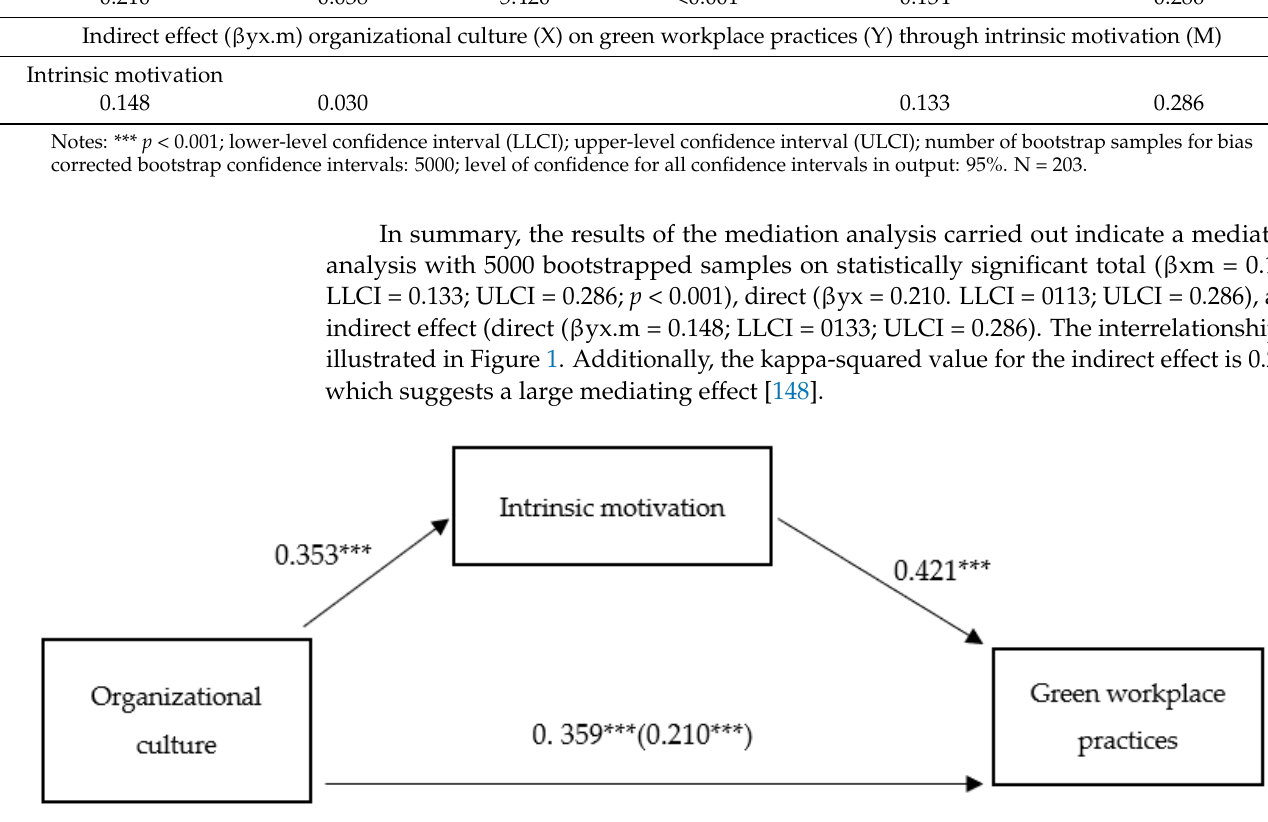
Figure 1. Parallel mediation model (N = 203). Indirect effects of organizational culture on green workplace practices through intrinsic motivation. Standardized effects estimates are presented. The effects on the direct path from organizational culture to green workplace practices depict the direct effect and the total effect (in brackets). *** p = 0.210, p = 0.359, p < 0.001.